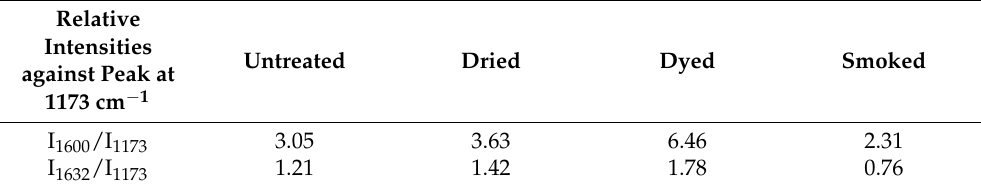
Table 1. Ratio of normalized heights of the absorption peaks of control and modified